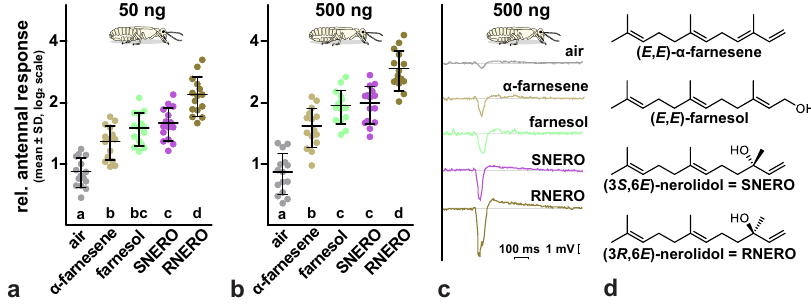
Fig. 6 Olfactory responses of female nymphs show a signi fi cant preference for RNERO over its opposite enantiomer and related sesquiterpenoids. a and b Graphs show EAG responses (amplitude values) of NY4 ♀ to air, RNERO, its opposite ( S ) enantiomer (SNERO) and two other structurally related sesquiterpenoids, ( E , E )- α -farnesene and ( E , E )-farnesol at doses of 50 ng ( a ) and 500 ng ( b ) of stimuli. The graphs show the means (±SD) of 15 independent stimulation series with randomized order of stimulations, related to responses to hexane stimulations; log 2 scale is used. ANOVA test for both used doses revealed signi fi cant differences in antennal responses to different stimuli, with means ranked in the order: air < α -farnesene < farnesol < SNERO < RNERO (50 ng: F 4,70 = 43.5, p < 10 − 4 ; 500 ng: F 4,70 = 62.2, p < 10 − 4 ). Columns marked with different lowercase letters differed signi fi cantly at α = 0.05 when compared using Tukey ’ s multiple comparison test among all pairs of columns. Detailed test statistics are provided in the Supplementary Data 1 fi le. c EAG response traces showing one stimulation series using 500 ng of the compounds. d Structures of the tested compounds.